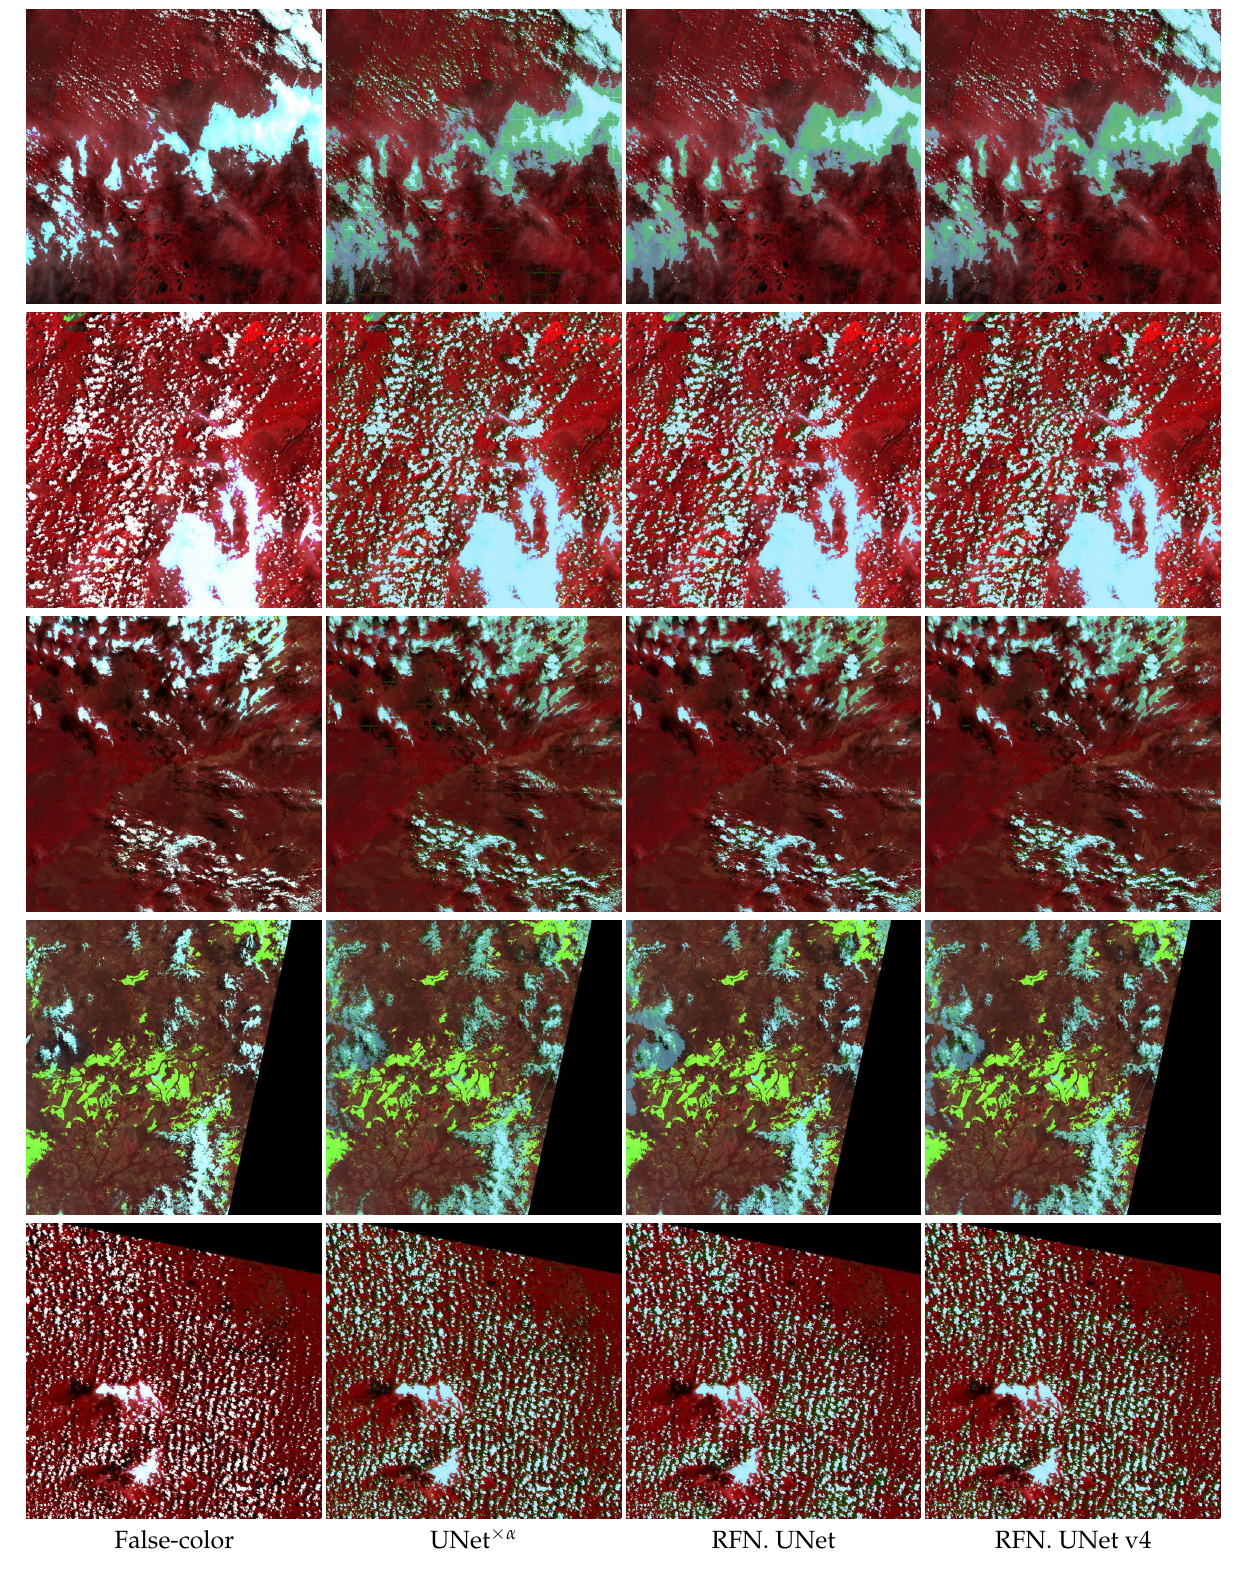
False-color UNet × α RFN. UNet RFN. UNet v4 Figure 3. Illustrations of segmentation proposals from a global perspective (2). Presented are the re- sults of 2014128223630.21KVB, 2017352224828.21KXB, 2019241223346.21KXB, 2020261220853.21KZB, and 2020271224917.20LQQ,